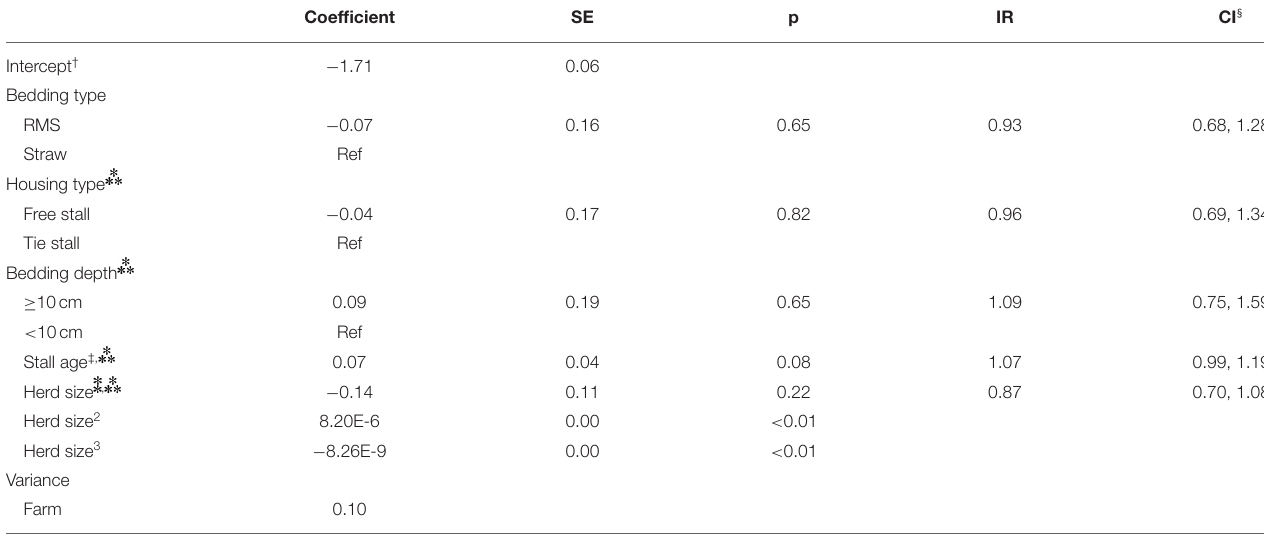
TABLE 3 | Impact of bedding type on the risk of a DHI test with a linear score > 4.0 in 11,031 cows from 20 RMS farms and 60 straw-bedded farms and estimated using a generalized linear mixed